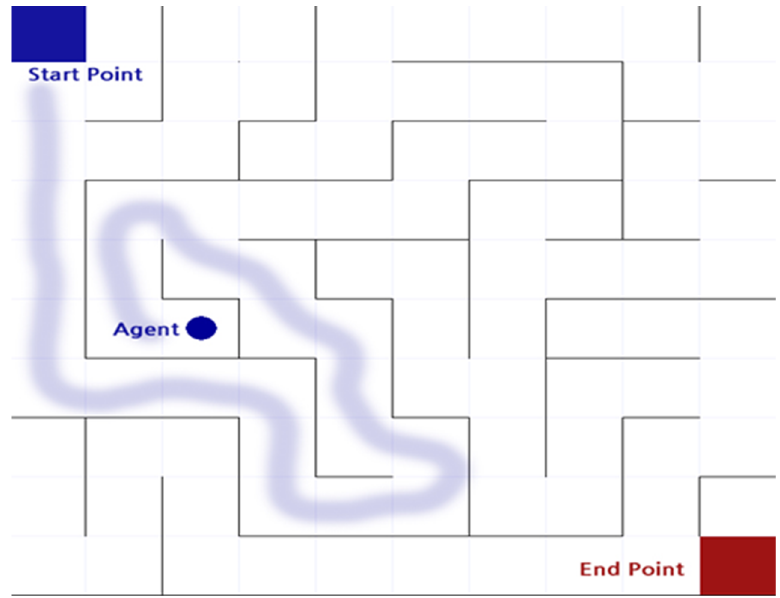
Figure 2. The maze game implemented through Python.